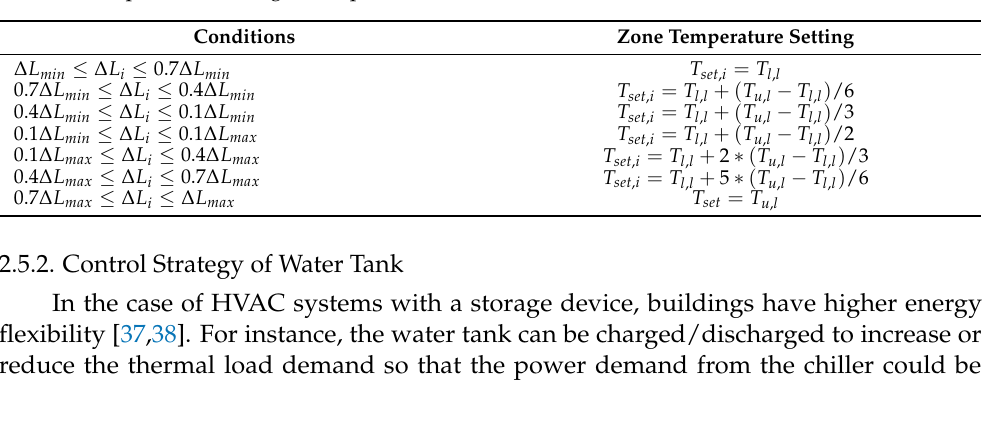
Table 2. Temperature setting in the prediction-based DR